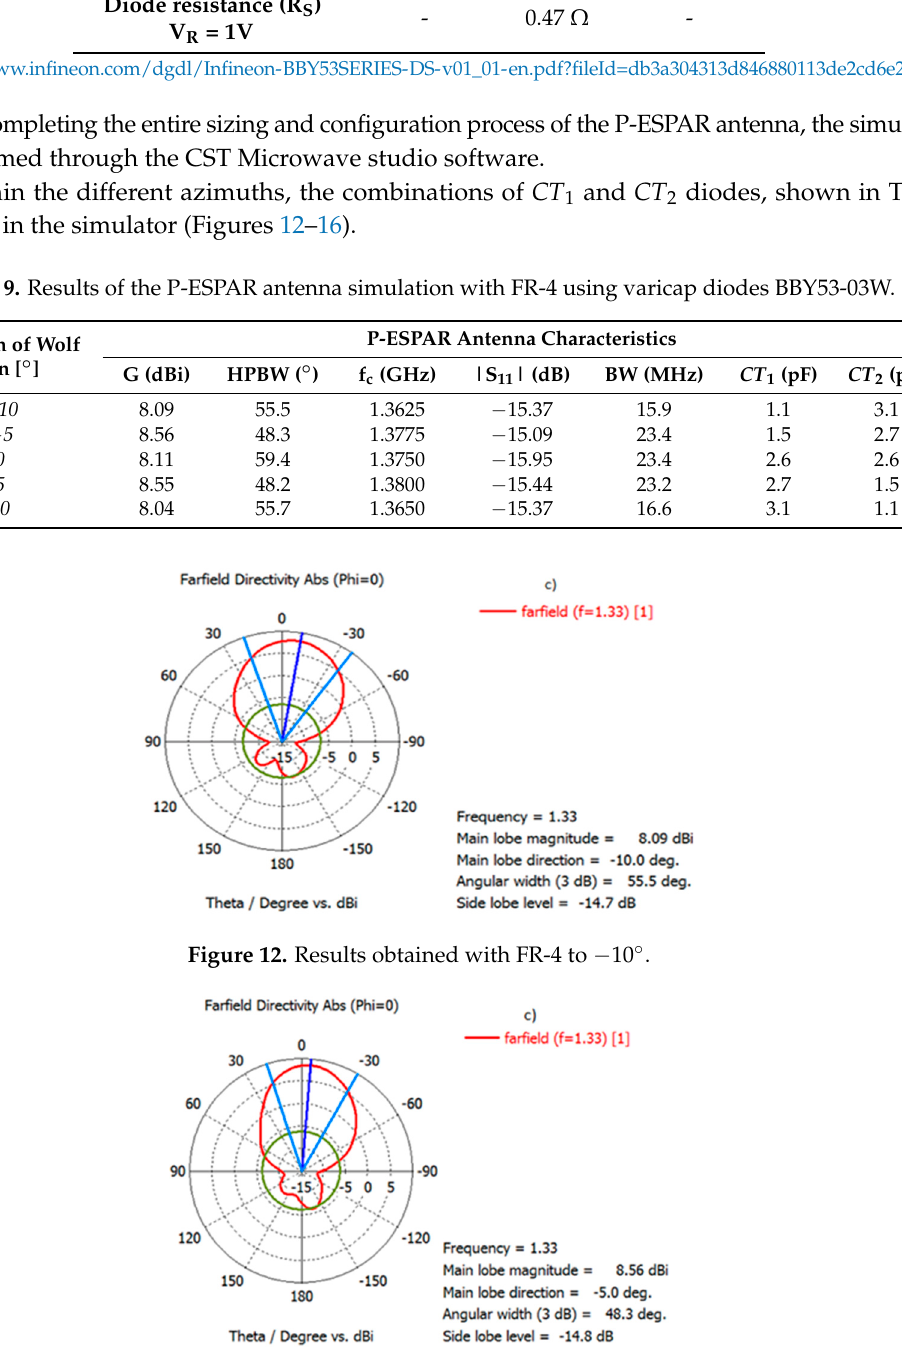
Figure 14. Results obtained with FR-4 for 0° . Figure 15. Results obtained with FR-4 for 5°. Figure 16. Results obtained with FR-4 to − 10°.